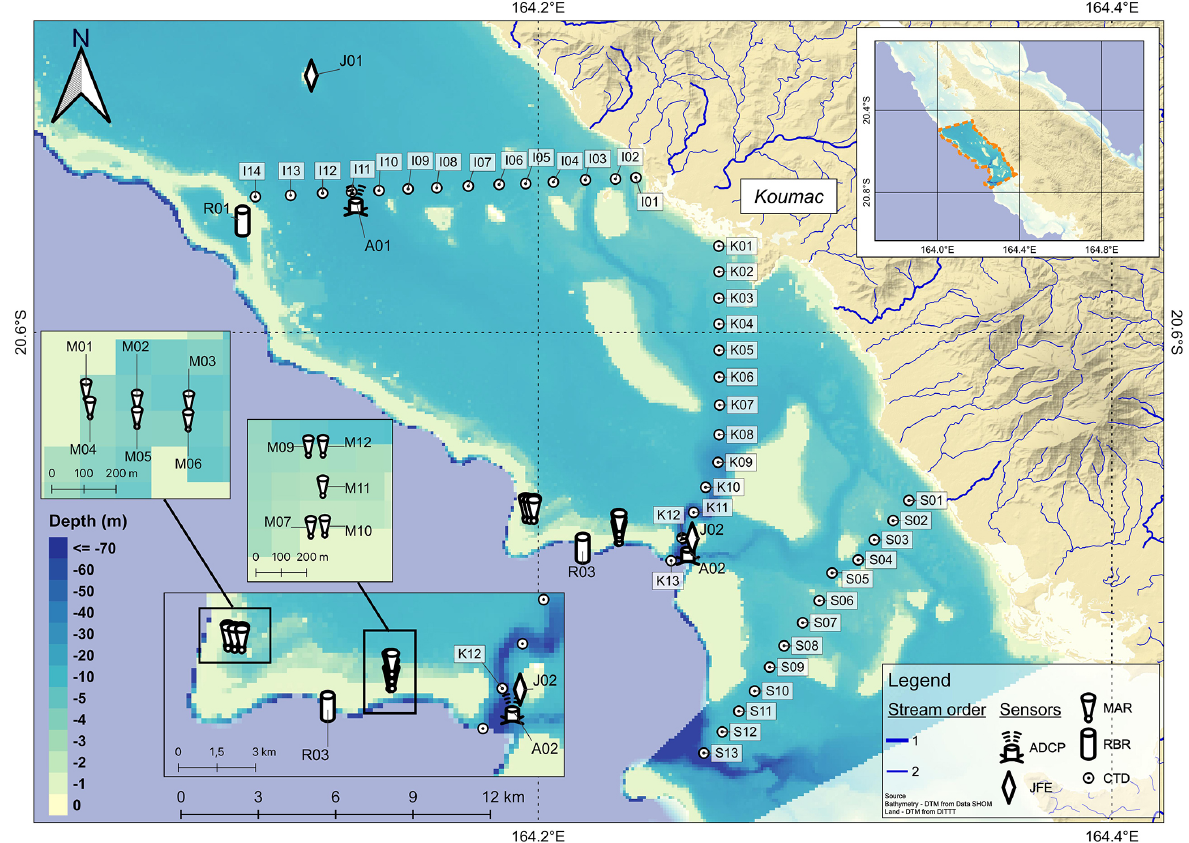
Figure D1. Observational strategy deployed during CADHYAK field experiment. ADCP: acoustic doppler current profiler; JFE: INFINITY- CTW; MAR: Marotte HS; RBR: RBRduo T.D or RBRduet T.D; CTD: conductivity – temperature –